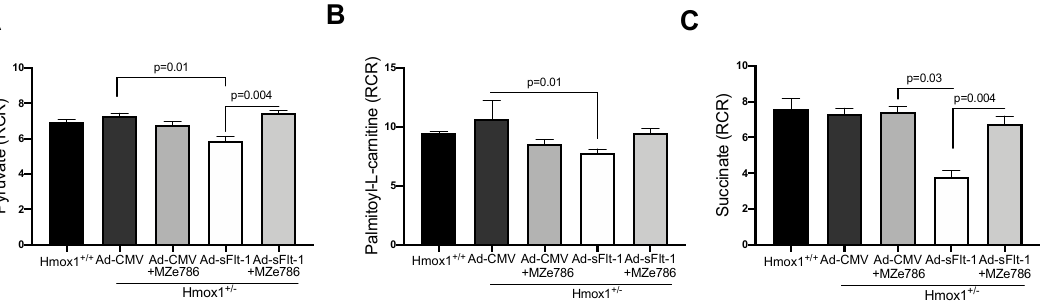
Figure 3. sFlt-1 inhibits cardiac mitochondrial activity in Hmox1 partial deficient mice. Mitochondrial oxygen consumption was measured in isolated cardiac mitochondria from Hmox1 +/ − mice injected with Ad-sFlt-1 and Ad-CMV injected Hmox1 +/ − mice exposed to MZe786 via gavage. The respiratory control ratio (RCR) (state 3 / state 4o) was calculated using complex I-driven substrates: ( A ) pyruvate and ( B ) palmitoyl-L-carnitine. ( C ) RCR was calculated in complex II-stimulated cardiac mitochondria Antioxidants 2020 , 9 , x FOR PEER REVIEW using succinate as substrate. Values are expressed as means ± SEM. N = 4.